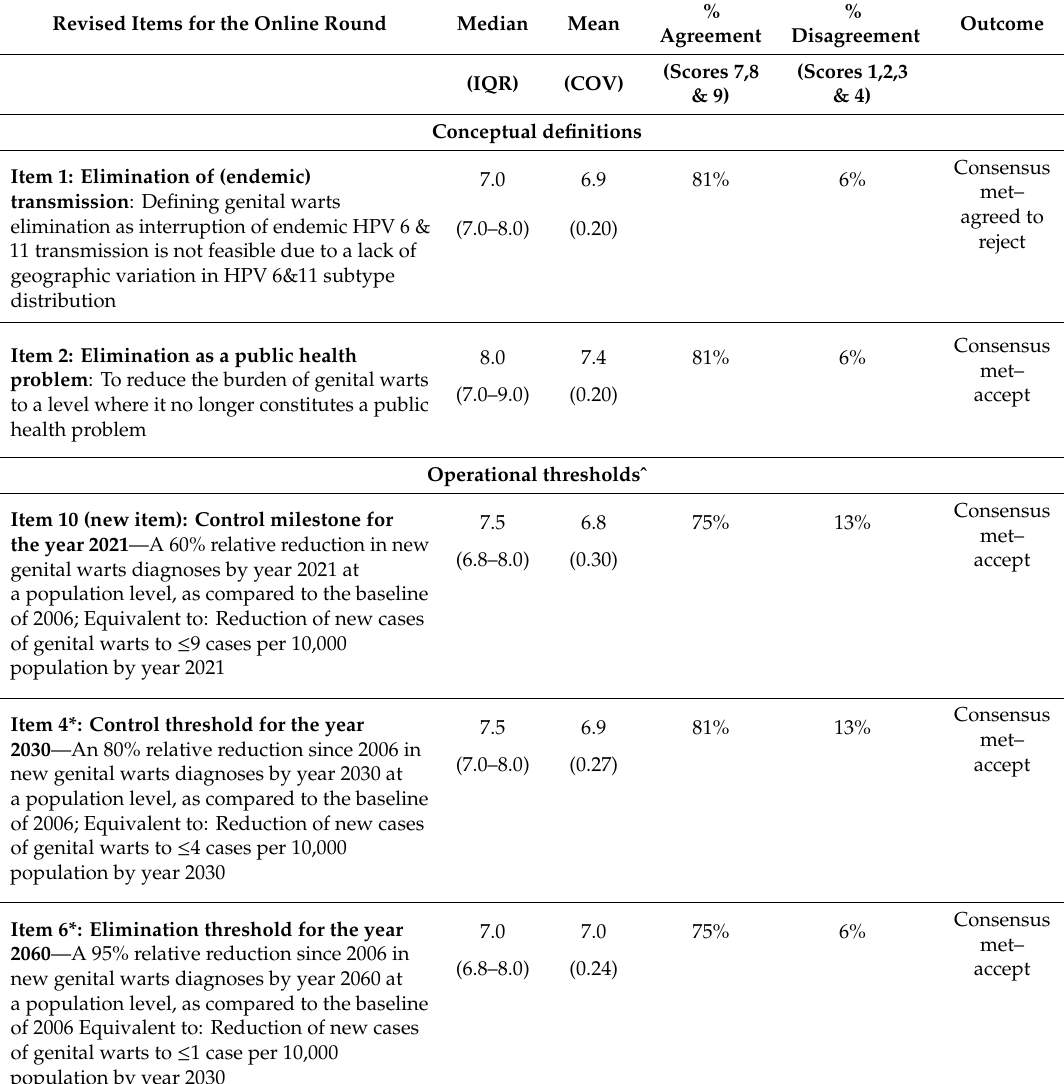
Table 4. Questionnaire and results of the third online